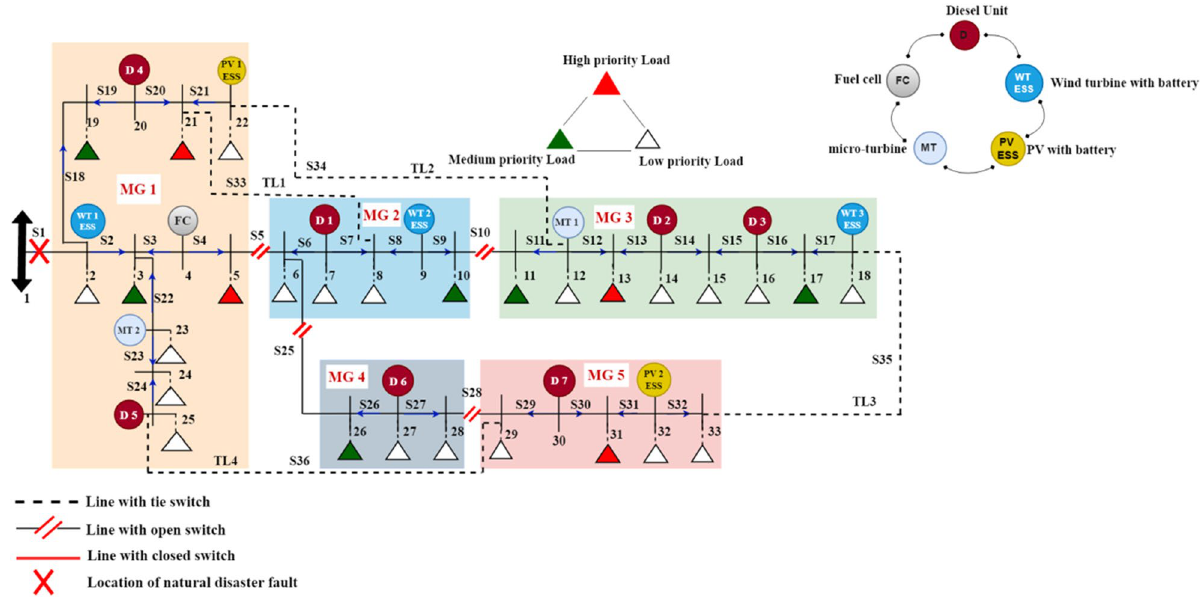
Figure 7. The optimal MG formation scenario with